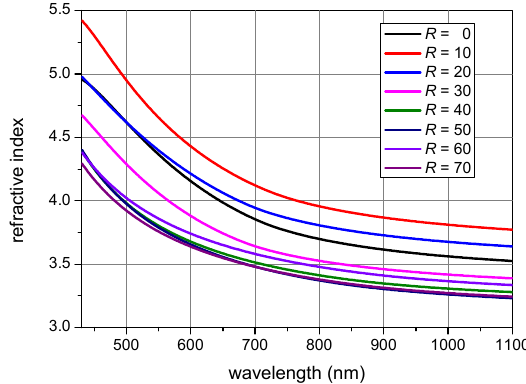
Figure 1. Refractive indices n [19].